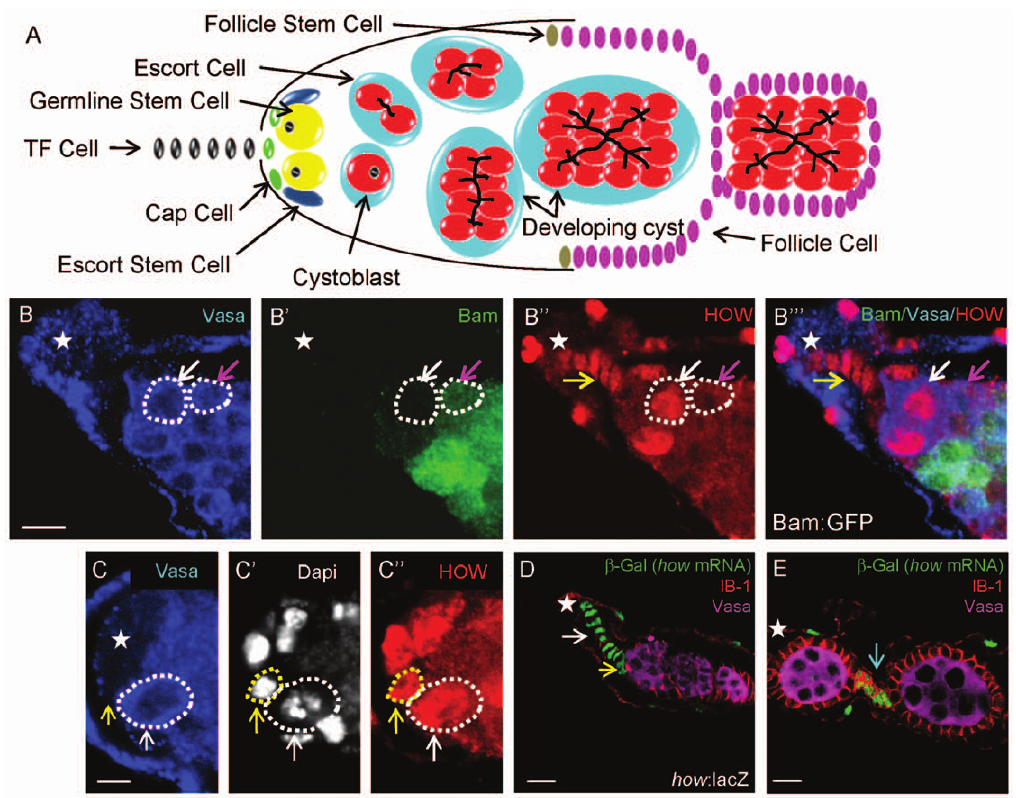
Figure 1. HOW is expressed in the early female germline. ( A ) schematic of the anterior region of an ovariole. GSCs (yellow) are anchored to Cap Cells (green). GSCs divide asymmetrically to produce one self-renewed daughter stem cell (yellow), and one cystoblast (red). The cystoblast divides four times to produce cysts of 16 interconnected cells. Escort stem cells (dark blue) are also in contact with cap cells and generate escort cells (light blue), while follicle stem cells (brown) produce follicle cells (magenta) and stalk cells. ( B ) Anti-HOW (red) labels GSCs (white arrow) and cystoblasts. HOW levels are reduced by the 2-cell stage (magenta q ) when Bam expression (green) is first detected ( bam ::GFP reporter). HOW is present in the terminal filament (TF) cells (yellow q ), and ( C ) in cap cells (yellow q ) adjacent to Vasa-positive GSCs (white q ). ( D,E ) A b - Galactosidase stain on a how :lacZ enhancer trap shows presence of lacZ in the somatic cells of the ovary, including terminal filament cells (white q ), cap cells (yellow q ), and stalk cells (blue q ). Scale bar 5 m m for B,D,E, 2 m m for C. Anterior marked (*).